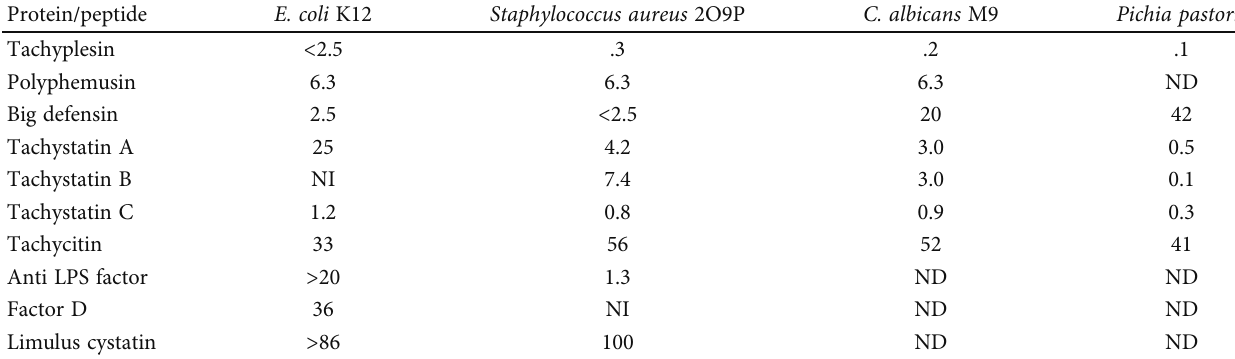
Table 4: Antimicrobial activities (IC50 μ g/ml) ∗ of the horseshoe crab hemocyte-derived proteins and peptides [32]. Protein/peptide